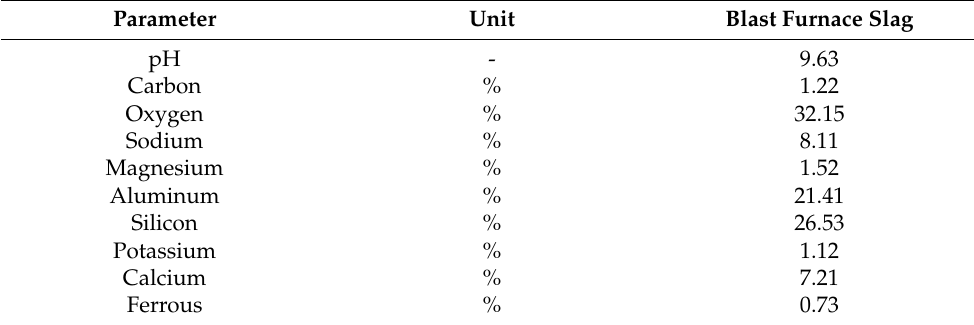
Table 1. Chemical composition of Blast Furnace